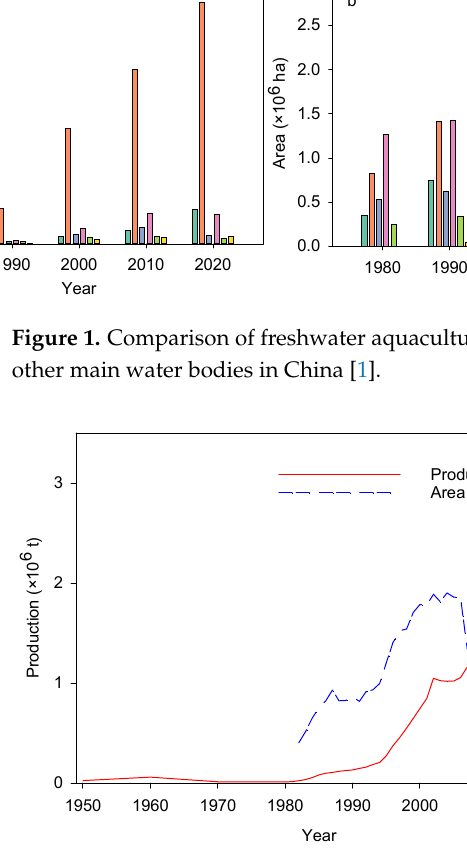
Figure 2. Changes in the aquaculture production and area in rice fields in China from 1950 to 2020 [1,5].